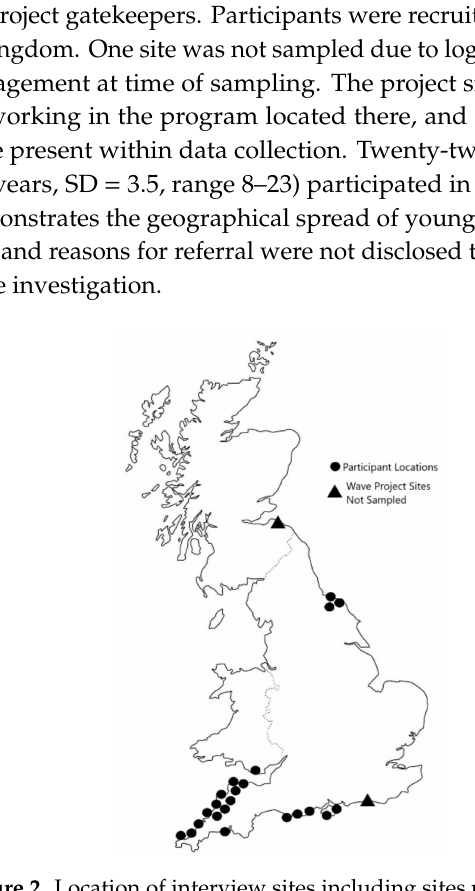
Figure 2. Location of interview sites including sites not